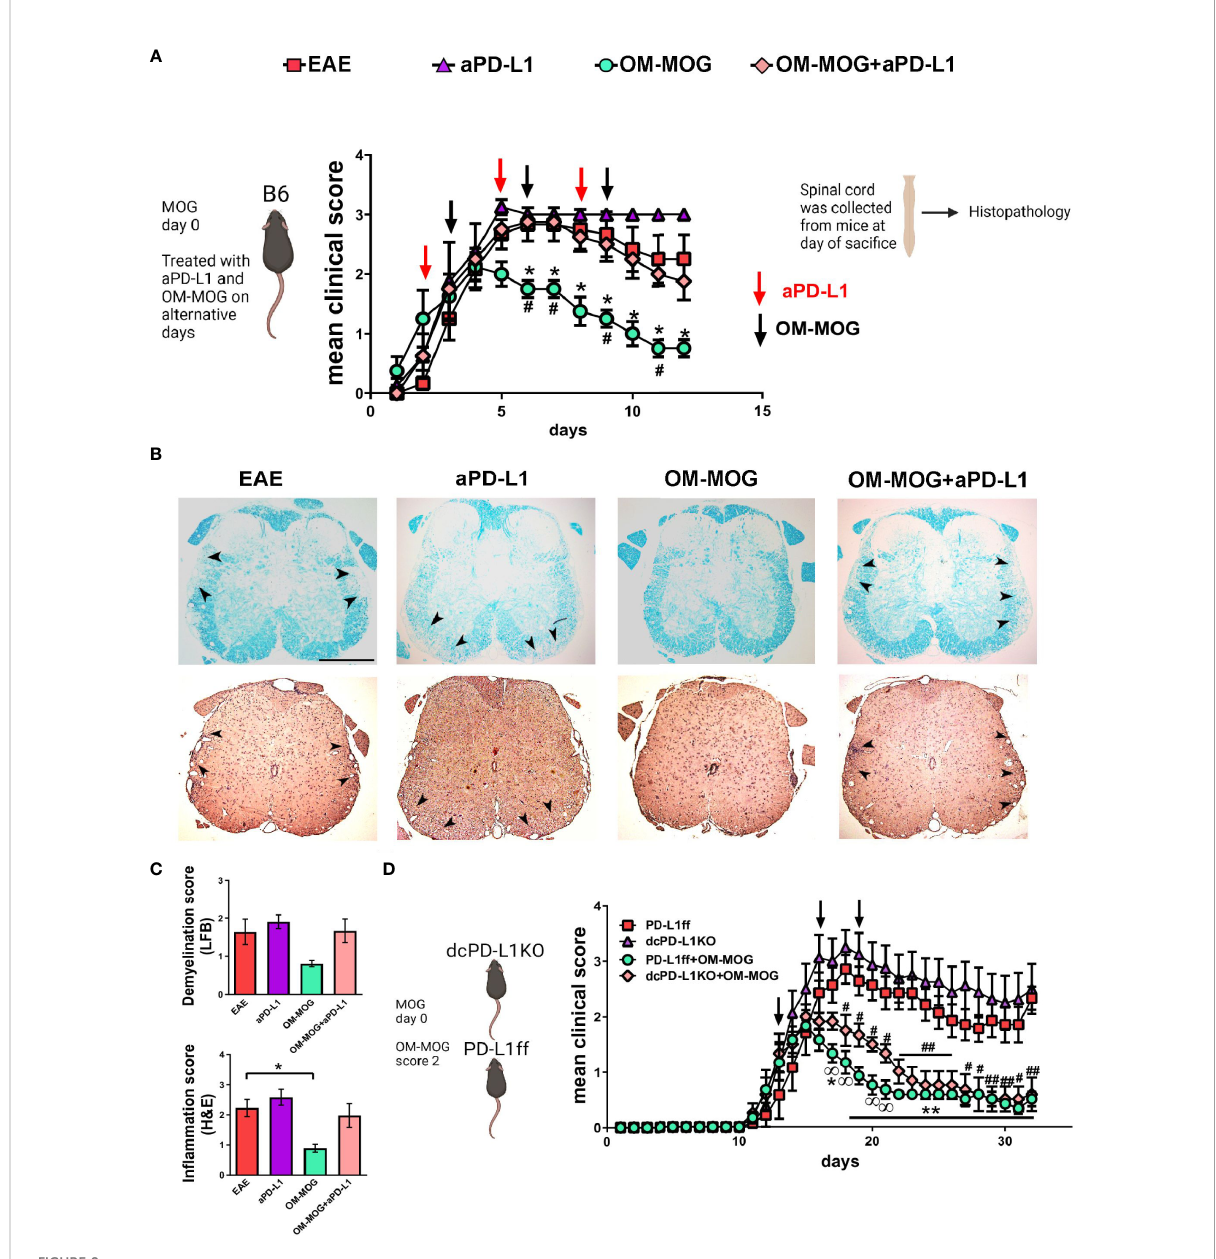
FIGURE 8 The protective effects of OM-MOG in EAE are abolished by PD-L1 neutralization and not altered by DC-speci fi c PD-L1 knockout. (A) Schematic representation of the overall experimental approach and the time points of injection of OM-MOG and anti-PD-L1 neutralizing antibody in the EAE mice. Mean clinical scores of EAE mice treated therapeutically with vehicle (EAE), OM-MOG (black arrows), anti-PD-L1 neutralizing antibody (red arrows), or both OM-MOG and anti-PD-L1 antibody (n=4-6/group). Disease onset was synchronized according to the start of disease in each mouse, occurring between dpi 10-12, so that each mouse was monitored for the same number of days and received the same number of injections. (B) Histopathological analysis of spinal cord sections taken from mice shown in (A) at the completion of the experiment. Demyelination was measured by Luxol fast blue staining (LFB; upper panels) and in fl ammatory in fi ltration by haematoxylin-eosin staining (H&E; lower panels). Con fl uent in fl ammatory demyelinating lesions characteristic of EAE are seen in mice treated with vehicle (EAE), anti-PD-L1 antibody and both OM-MOG and anti-PD-L1 antibody (arrowheads), in contrast to markedly reduced lesions in mice treated with OM-MOG. Representative images from 1 of 4 or 6 (EAE) mice/group are shown. Scale bar 500 m M. (C) Semi-quantitative analysis of LFB and H&E-stained spinal cord sections of the mice shown in (A) . 6-7 sections per mouse were analyzed (n=4-6 mice/group). (D) Mean clinical scores of PD-L1ff and dcPD-L1KO EAE mice treated therapeutically with vehicle (EAE) or OM-MOG (black arrows) (n=6-8/group). Data and statistical analysis are from one experiment in each case (one for A-C , one for (D) . Statistical signi fi cance is shown after comparisons between groups using Mann- Whitney test ( A , *EAE vehicle versus OM-MOG; # OM-MOG vs OM-MOG+anti-PD-L1) ( D , *PD-L1ff EAE vehicle versus PD-L1ff+OM-MOG; # PD- L1ff EAE vehicle versus dcPD-L1KO+OM-MOG; PD-L1ff+OM-MOG versus dcPD-L1KO+OM-MOG), and one-way ANOVA followed by Tukey ’ s post hoc test (C) (*, #, p ≤ 0.05, **, ## p ≤